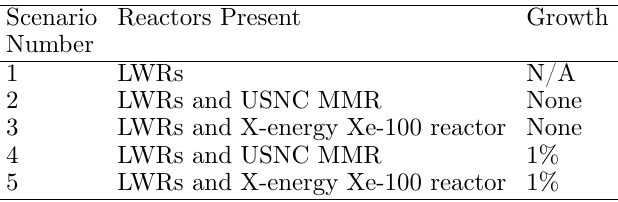
Table 1. Summary of the fuel cycle scenarios Scenario Reactors